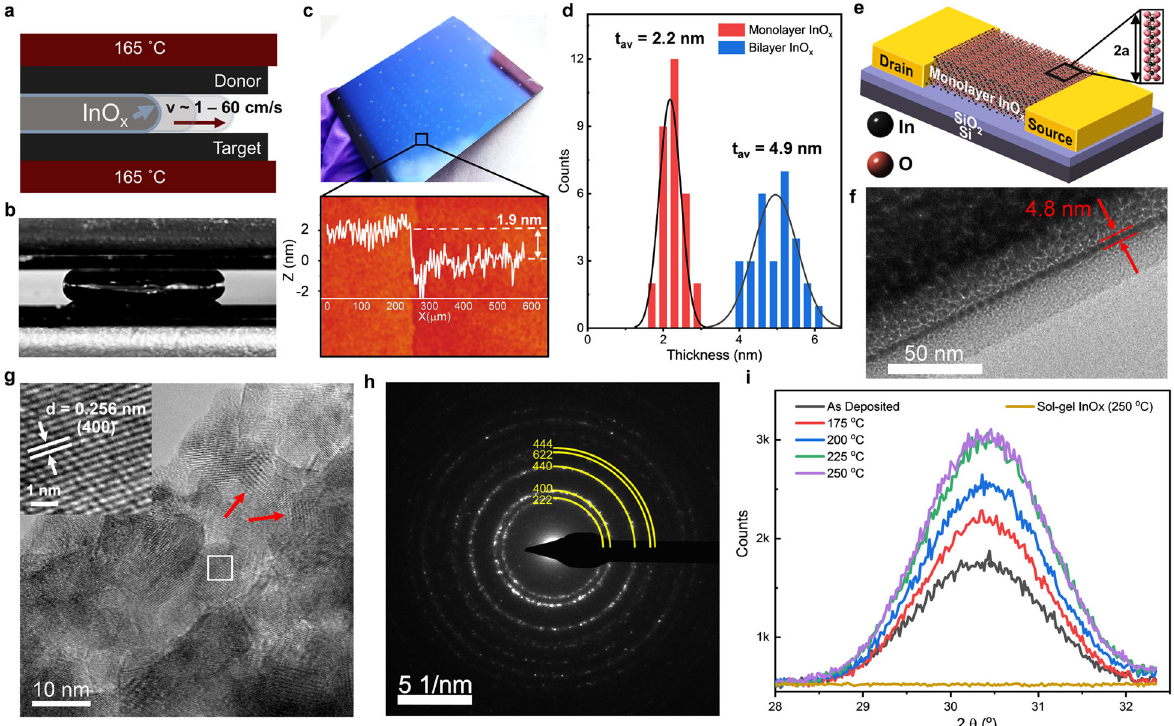
Fig. 1 Liquid metal printing schematic, TEM, and X-ray diffraction studies. a Schematic for liquid metal 2D oxide deposition and b photograph of liquid metal droplet during pneumatic pressing process. c Large area (30 cm 2 ) array of 2D InO x semiconductors (top) with height map (bottom) showing line scan for a monolayer fi lm. d Histogram of measured thicknesses for monolayer and bilayer InO x fi lms. e Atomic-scale illustration of monolayer InO x channel transistor two unit cells thick. f Cross-sectional TEM image of 2D InO x fi lm. g HRTEM image of the 250 °C annealed InO x nanosheet. The inset shows a magni fi ed view of the lattice pattern within a nanograin. Red arrows highlight Moiré fringes. h SAED pattern for postannealed bilayer InOx nanosheet. i XRD scans of the (222) peak for bilayer InO x fi lms postannealed at various